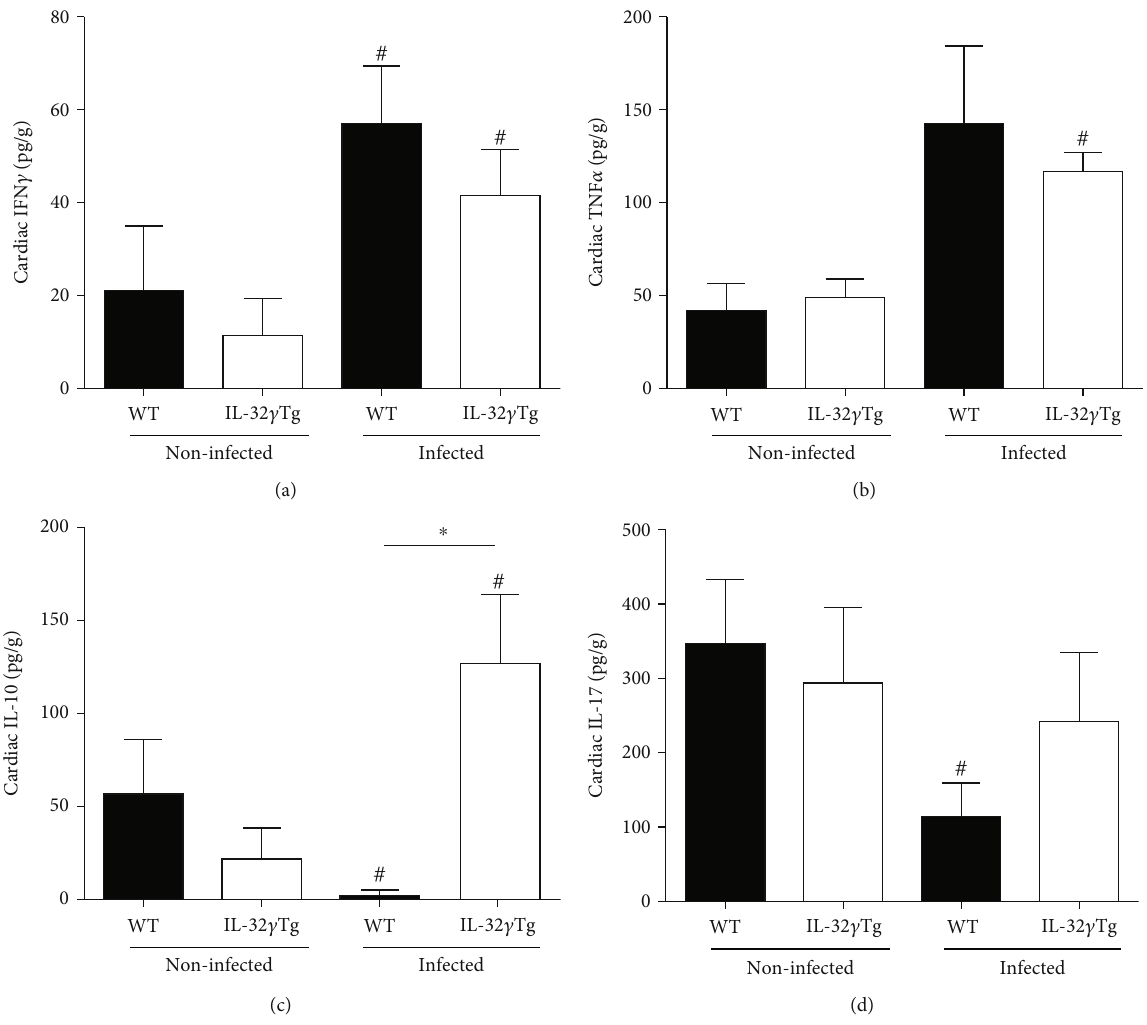
Figure 5: E ff ects of IL-32 γ on cytokine production in the hearts of mice infected with the Colombian strain of T. cruzi during acute phase of experimental Chagas disease. Quanti fi cation levels of (a) IFN γ , (b) TNF- α , (c) IL-10, and (d) IL-17 (pg/mg) in cardiac homogenates by ELISA. ∗ p < 0 : 05 (WT vs. IL-32 γ Tg mice), # p < 0 : 05 (noninfected vs. infected within the same group of animals, two-way ANOVA test with Bonferroni post hoc